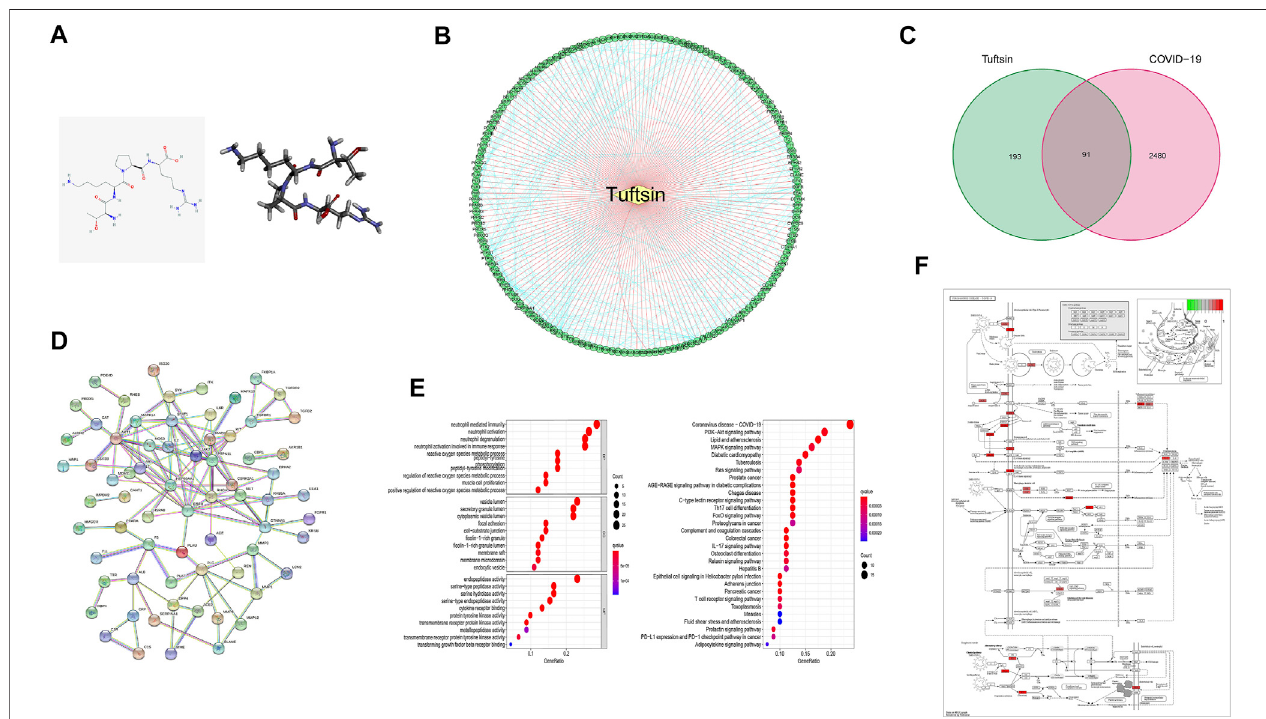
FIGURE1| TheconnectionbetweentuftsinandCOVID-19. (A) (Left)The2DchemicalstructureoftuftsindownloadedfromthePubChemdatabase.(Right)The3D chemical structure of tuftsin established by software based on the 2D structure. (B) The “ drug-target ” network of tuftsin. Red links represent the interactions between tuftsinandtargetnodes.Eachnodeisaproteintarget.Greenpointsrepresentthetargetedproteinsinhumans.Bluelinksrepresenttheinteractionsbetweenthetargets. (C) AVenn diagram oftuftsin and COVID-19 cotargeted genes. (D) Protein – protein interaction(PPI) networkofthe intersected targets. The interactions withahigh con fi dence of 0.95. (E) (Left) Gene ontology enrichment results in bubble plot. (Right) The KEGG enrichment results in bubble plot. (F) Detailed targets of tuftsin in the COVID-19 pathway. Red points represent the tuftsin targets. The intensity of the color represents the possibility of tuftsin targeting. Deeper color indicates higher